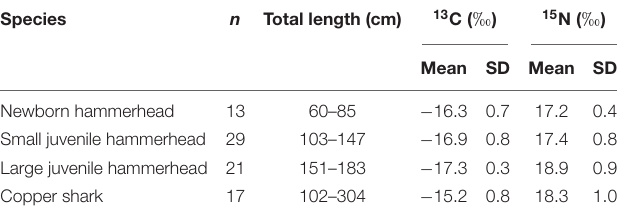
TABLE 3 | Mean isotopic values for size classes of hammerheads and copper sharks on Bahía Sebastián Vizcaíno. Species n Total length (cm)